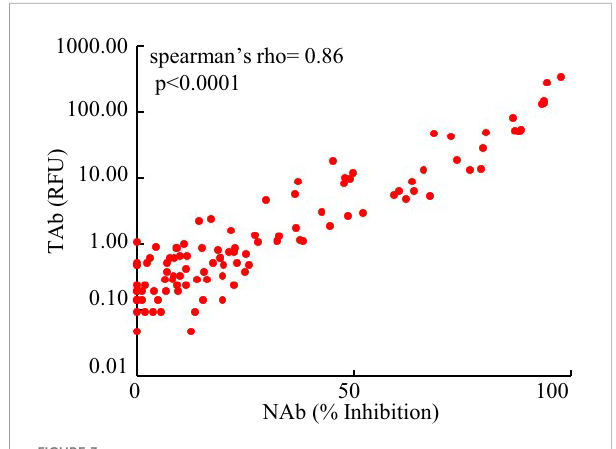
FIGURE 3 Comparison of the results of the Pylon TAb assays and the Pylon NAb assays (spearman ’ s rho= 0.86, p<0.0001).